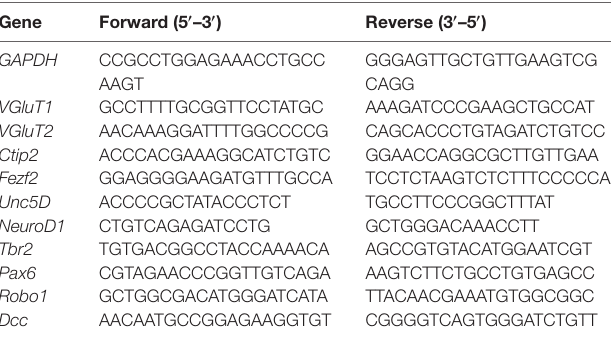
TABLE 1 | Primers used for polymerase chain reaction (PCR). Gene Forward (5 (cid:48) –3 (cid:48)